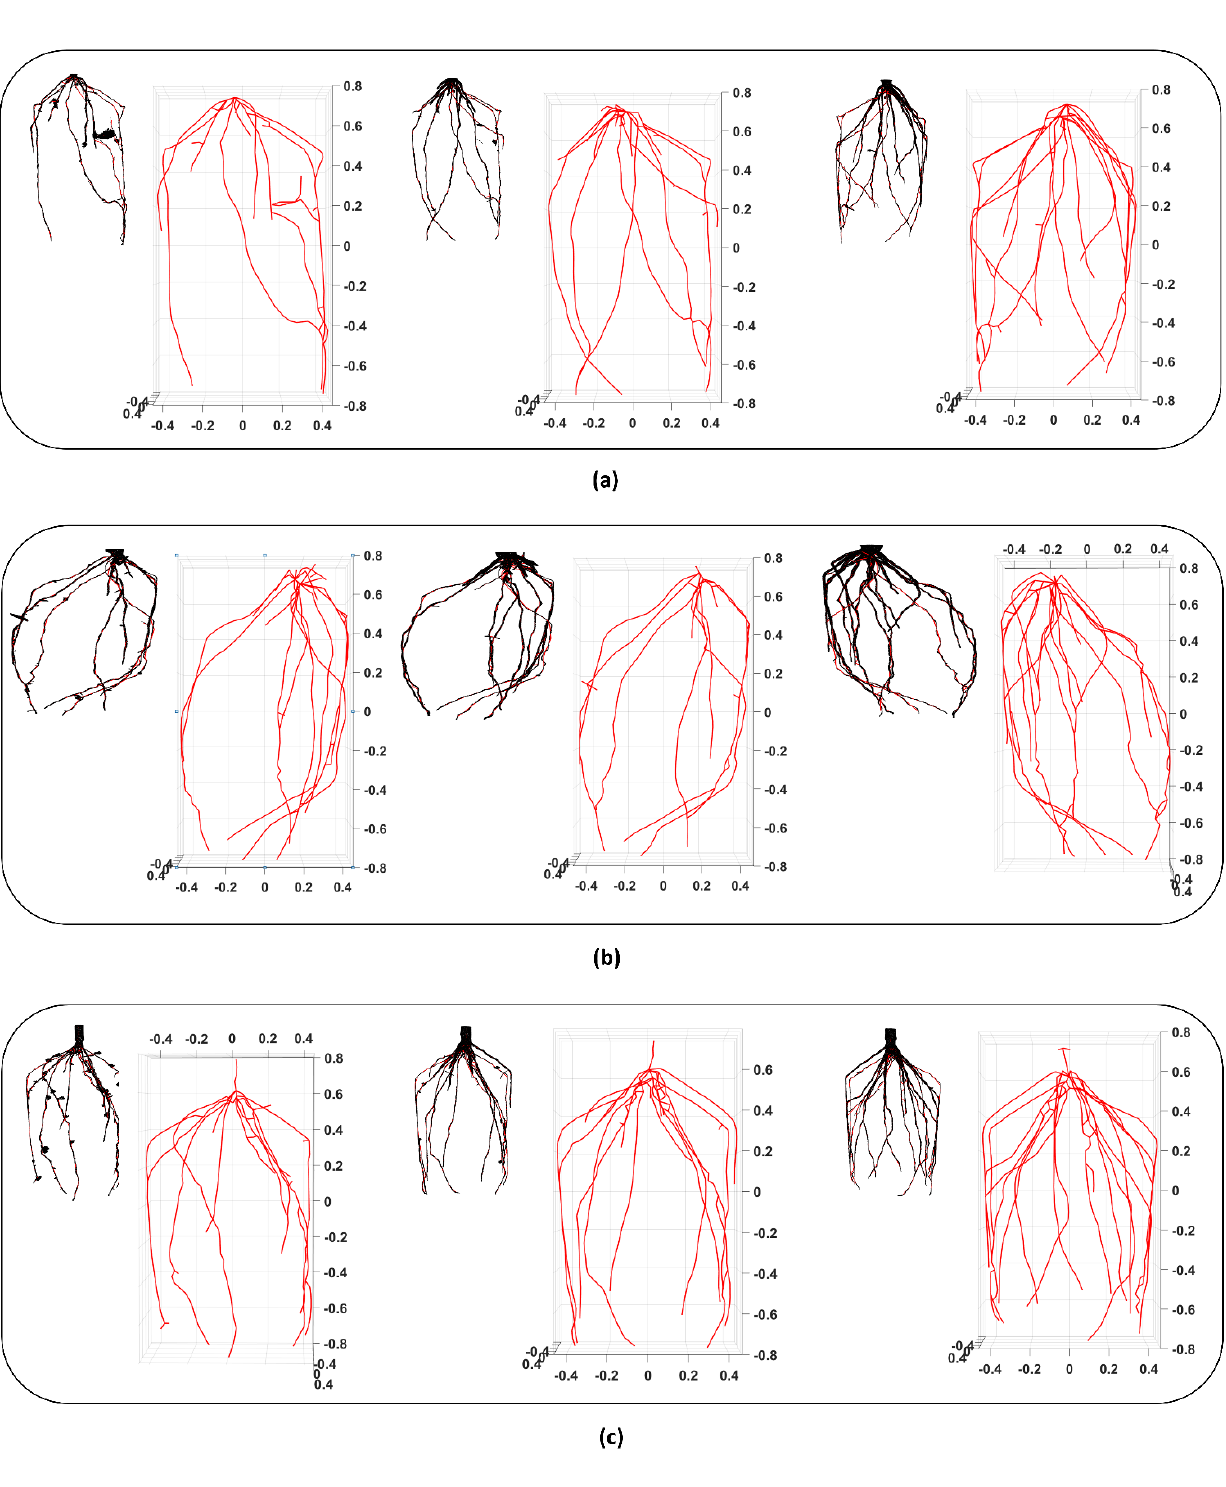
Figure 2. Skeleton of corn root samples in relative units and a small figure representing the digital twin in black with the embedded skeleton in red: scan ID 211, 212 and 213 (a), scan ID 221, 222 and 223 (b) and scan ID 231, 232 and 233